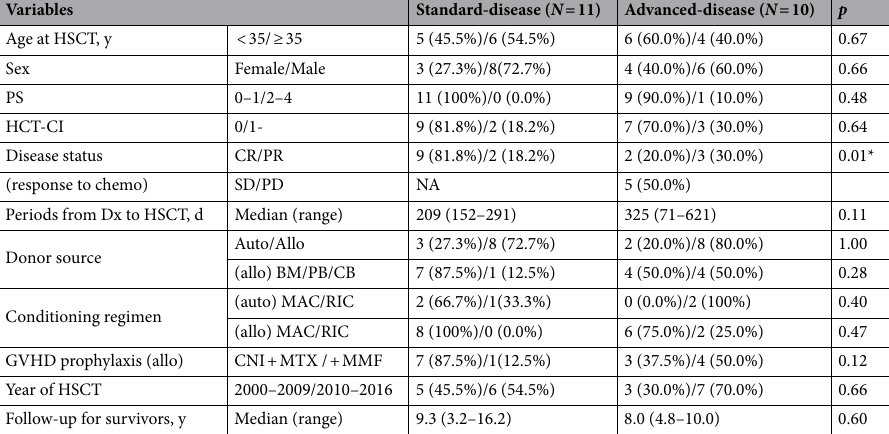
Table 2. Patient characteristics related to HSCT. HSCT hematopoietic stem cell transplantation, HCT-CI hematopoietic cell transplantation-specific comorbidity index, CR complete remission, PR partial remission, SD stable disease, PD progressive disease, Dx diagnosis, Auto autologous, Allo allogeneic, PB peripheral blood, CB cord blood, MAC myeloablative conditioning, RIC reduced intensity conditioning, GVHD graft-versus-host